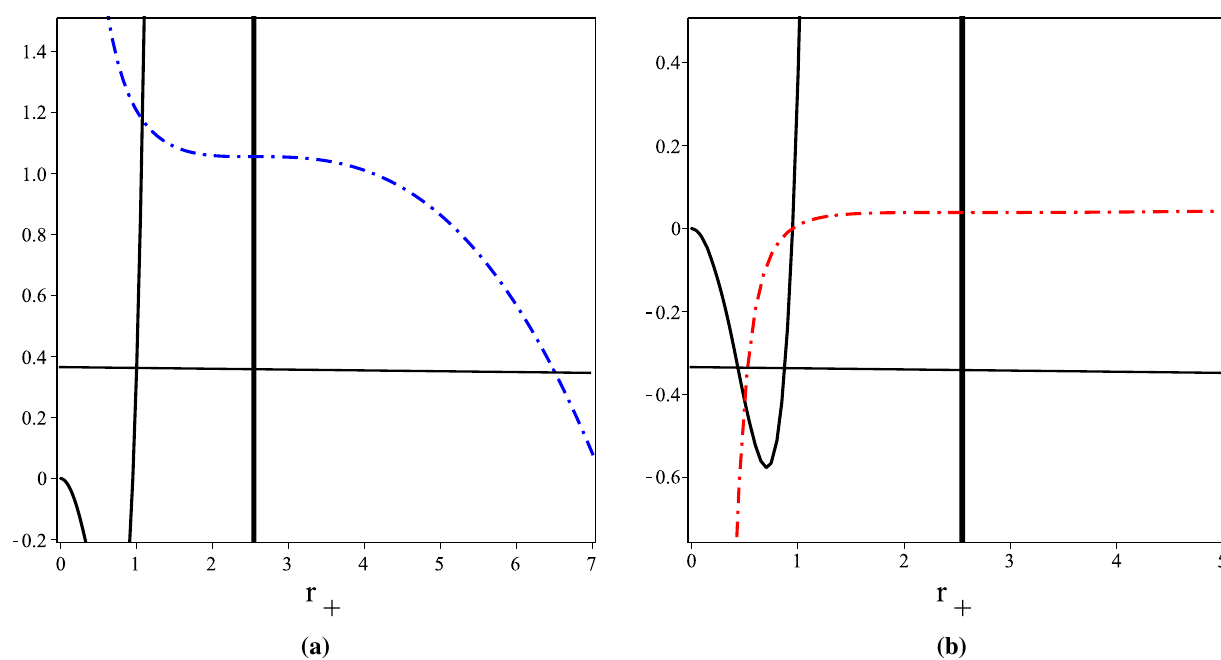
Fig. 6 The behavior of C P (solid line), T (dashed line) and G (dotted dashed line) in terms of r + for P c = 0 . 002669 , Q = 1